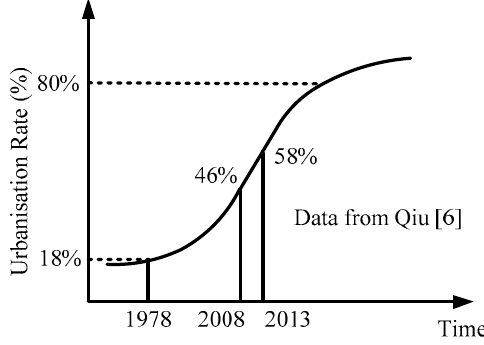
Figure 1. Variation of the urbanization rate for China.